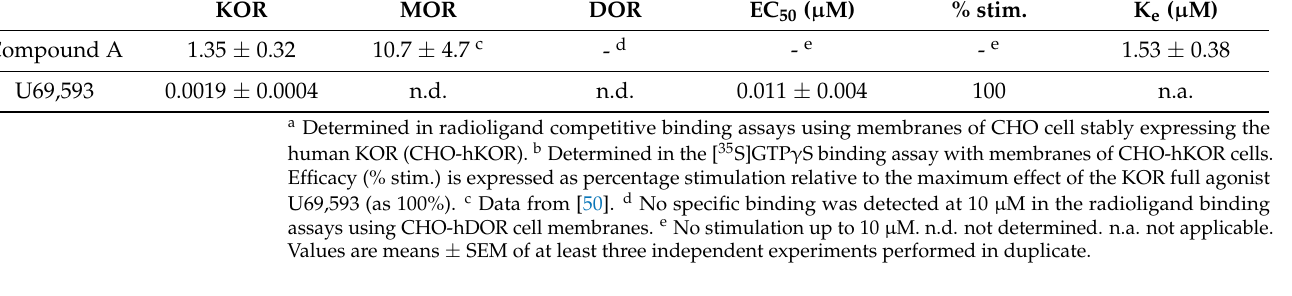
Table 1. In vitro binding affinities and functional activities of Compound A at the human KOR. Opioid Receptor Binding (K i , μ M) a